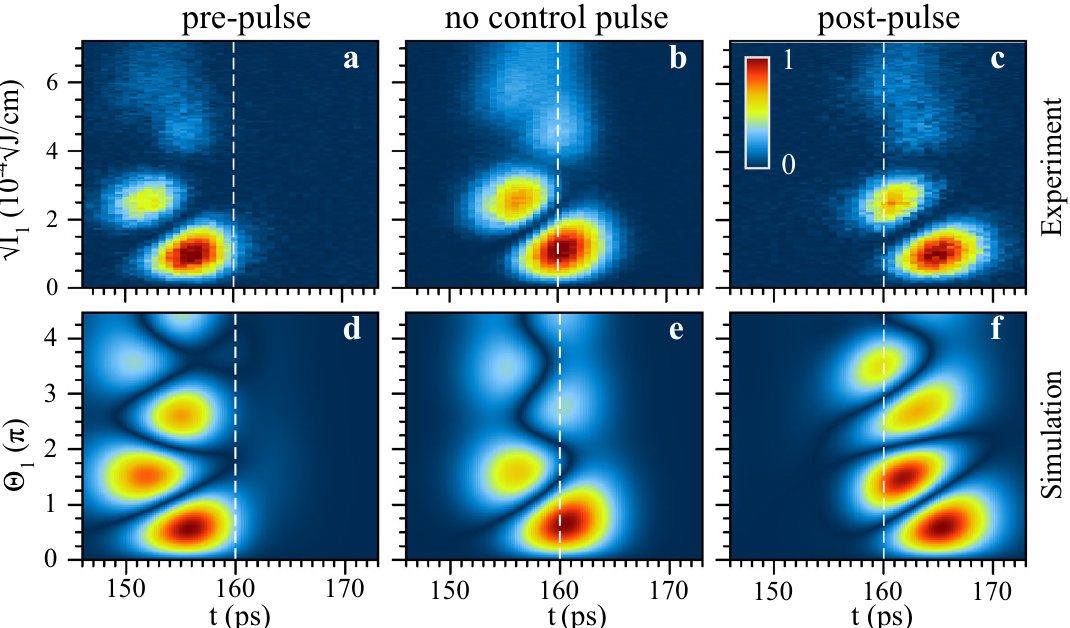
p ffiffiffi I ( a , d ) in 1